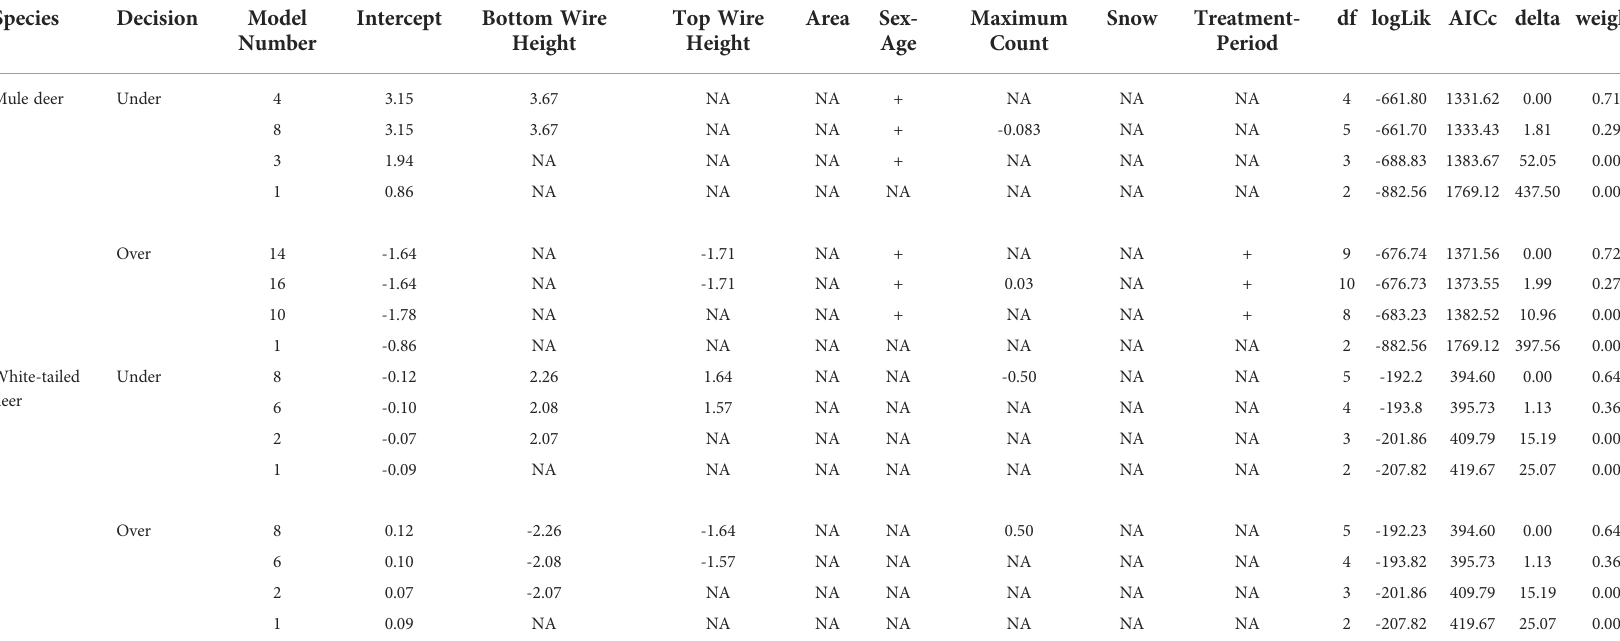
TABLE 2 Mixed effects logistic regression analysis results for factors affecting the crossing decision of mule deer and white-tailed deer. Species Decision